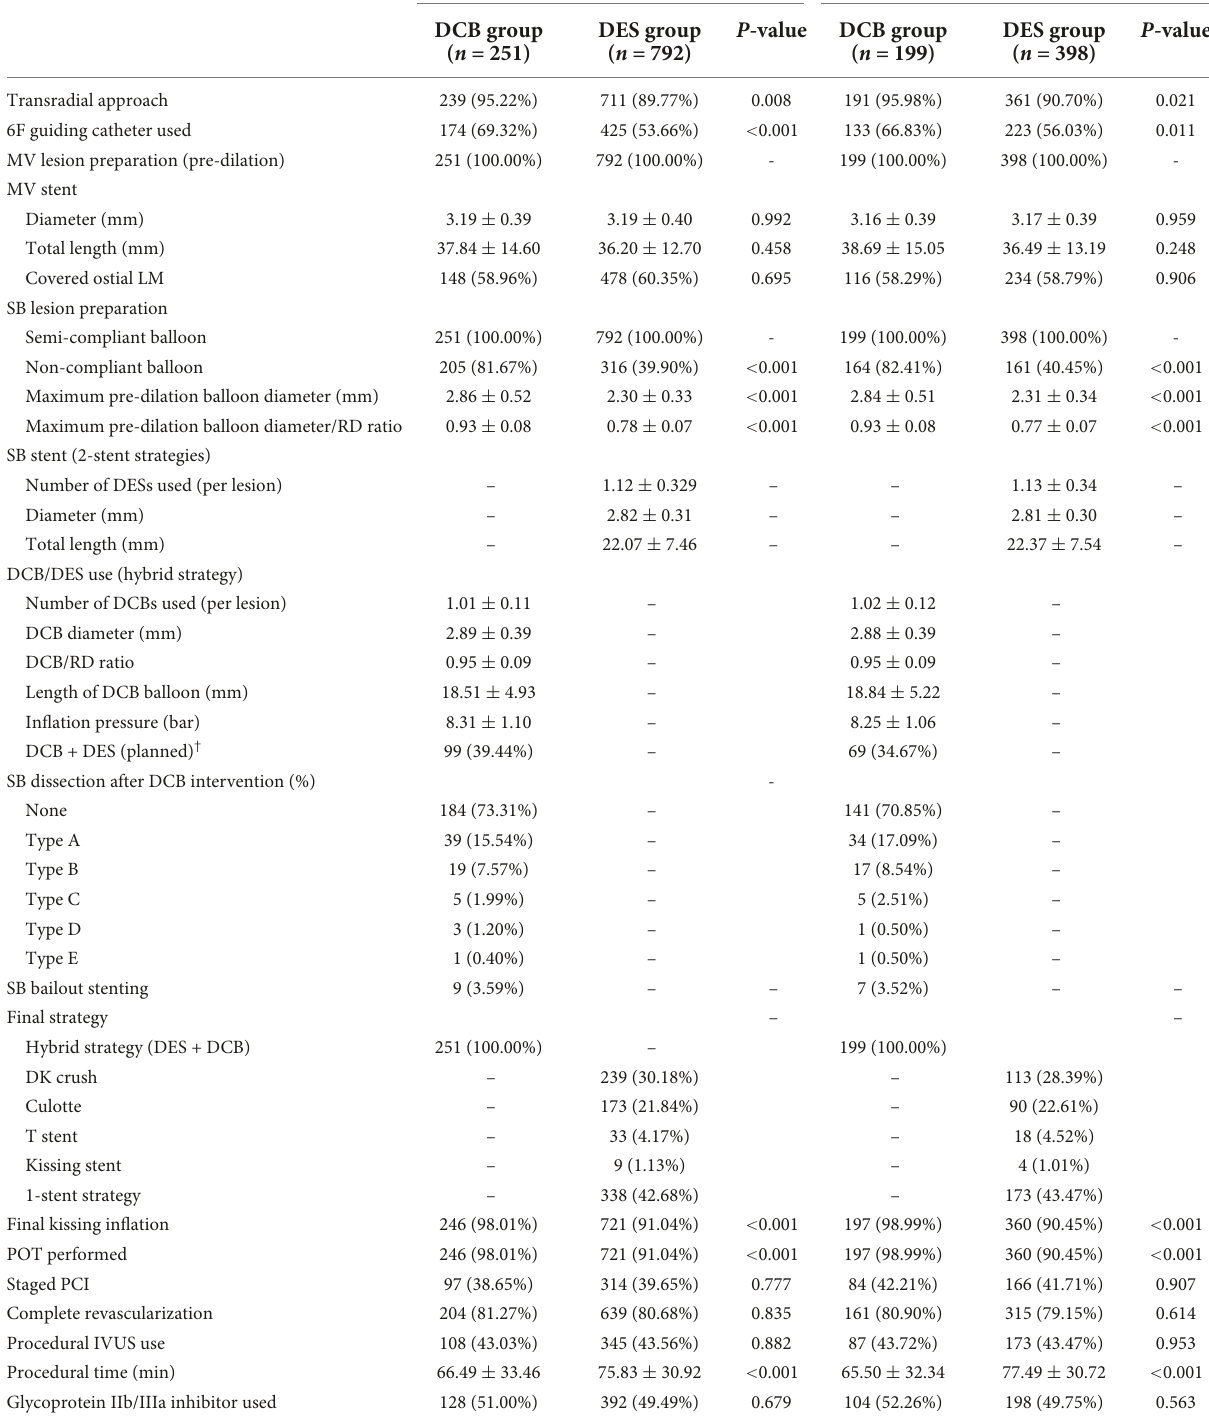
TABLE 3 Procedural characteristics before and after propensity-score